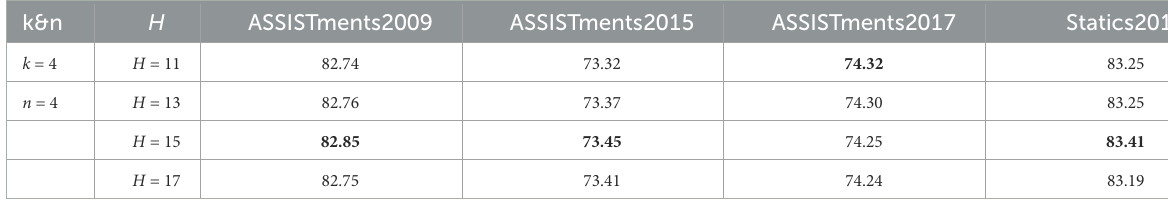
TABLE 6 The AUC results (%) for varying H .